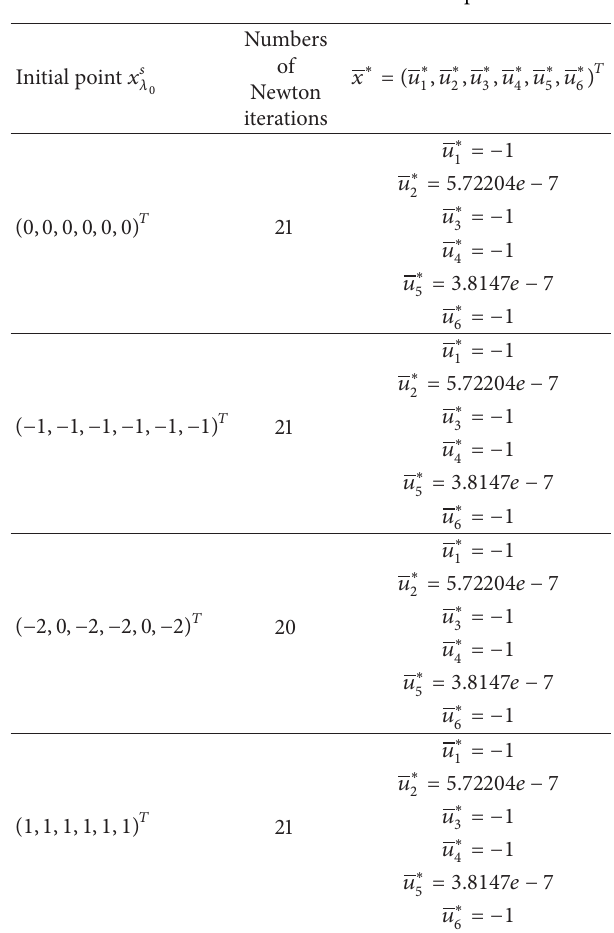
Table 2: The numerical results of Example 2. Table 3: The numerical results of Example 3.